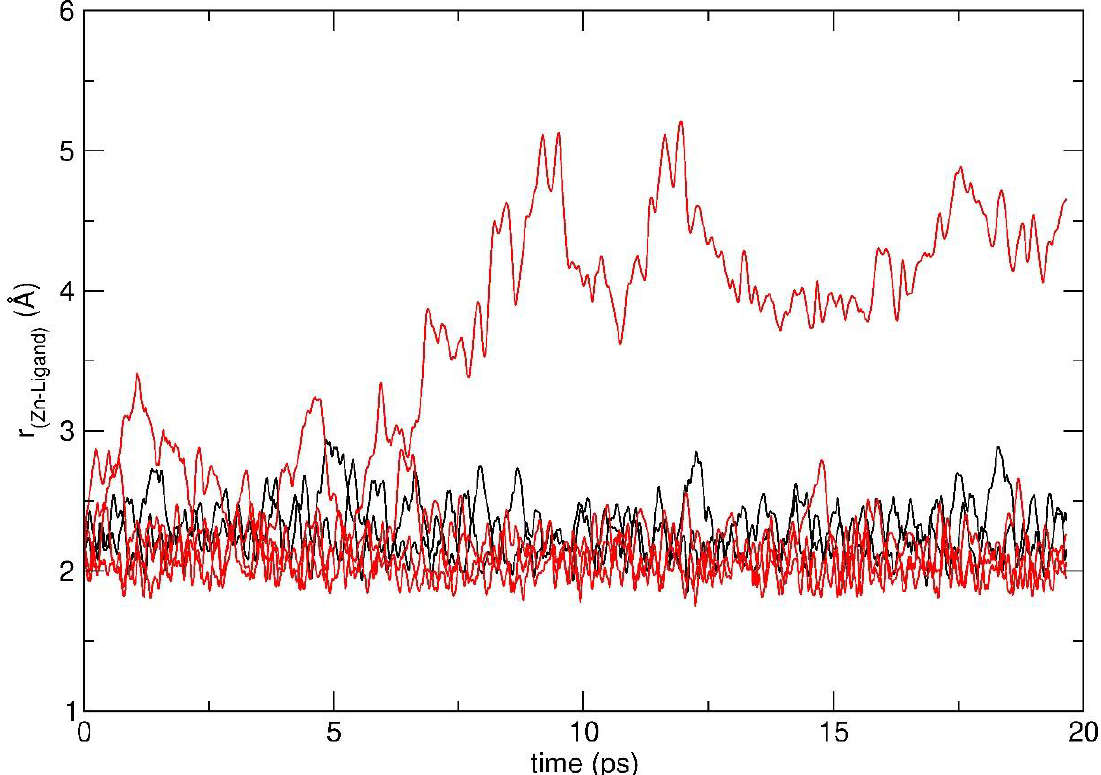
Figure 1. Variation of four Zn-O distances (red solid lines) and two Zn-N distances (black solid line) along the exploratory ab initio molecular dynamics (AIMD) simulation of the octahedral Zn(hfa) 2 TMEDA molecular complex on the hydroxylated silica surface.